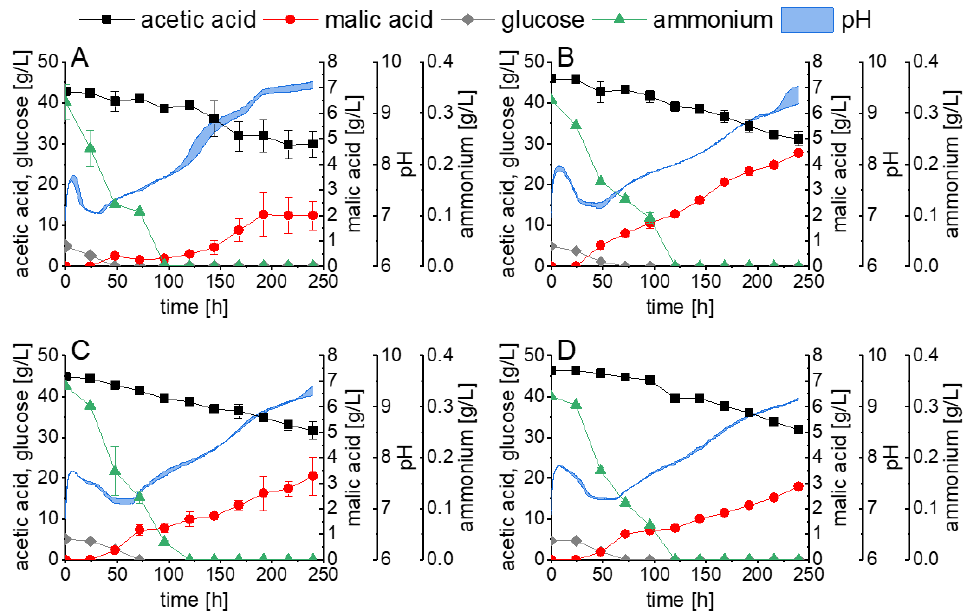
Figure 6. Malic acid production using acetate as carbon source in 2.5 L-bioreactors with free biomass ( A ) and A. oryzae immobilized in 3% alginate ( B ), 6% alginate ( C ), and 1.5% κ -carrageenan ( D ). Val- ues are means of duplicates with standard